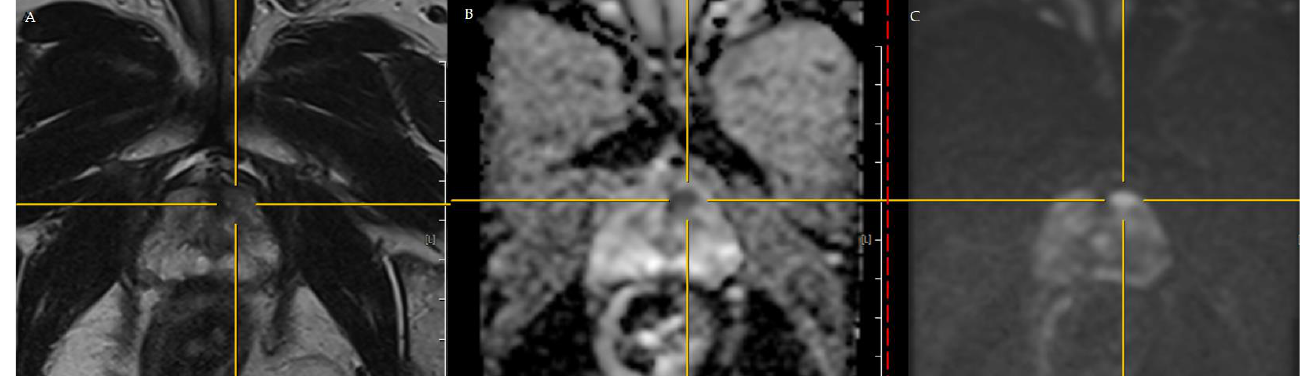
Figure 1. 3T mpMRI assessment of the prostate. There was a PI-RADS version 2 score 4 lesion at the left anterior peripheral zone. ( A ) T2-weighted image. ( B ) Apparent diffusion coefficient. ( C ) Diffusion-weighted imaging.